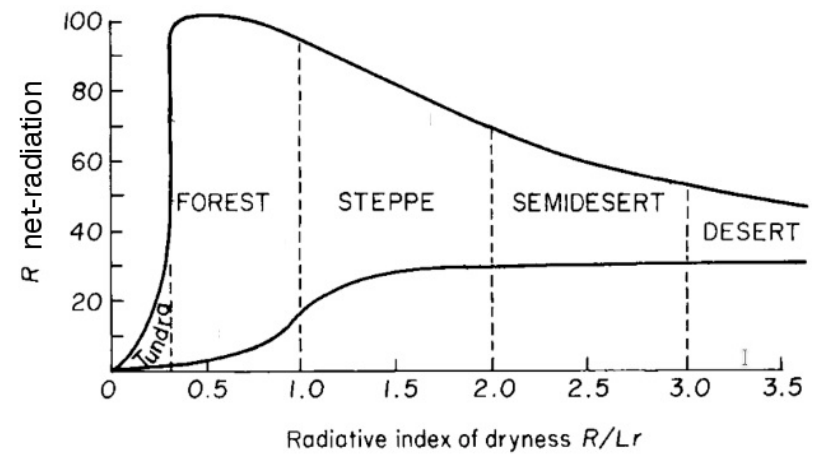
Figure 3. Diagram of the geobotanic zonality (adapted from Budyko et al 1974).